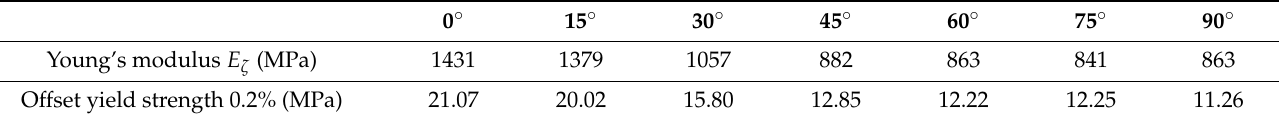
Table 2. Experimental results of tensile tests. 0 ◦ 15 ◦ 30